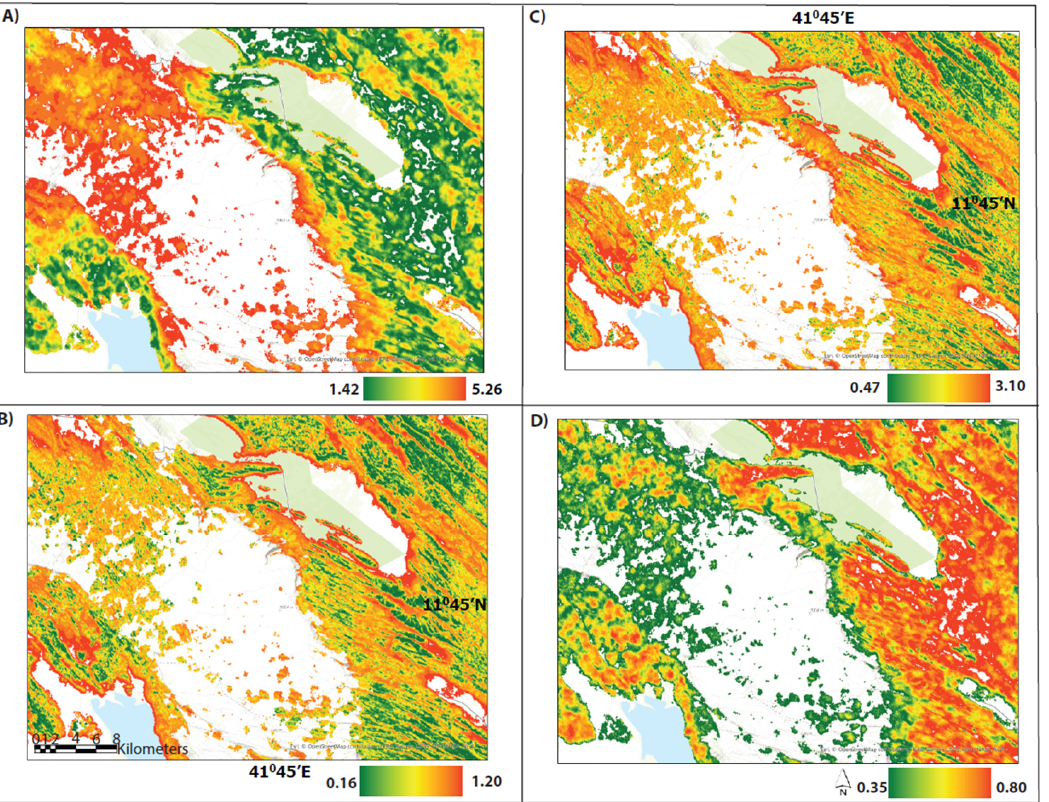
Figure 5. The quality of the InSAR results from descending tract 006 needed to be checked using several indices: ( A ) The Root Mean Square Error (RMSE); ( B ) Height Precision (HP); ( C ) Velocity Precision (VP) and ( D ) multi-temporal interferometric coherence, where the red-colored area is highly coherent. All the quality-control indices have a direct link to the quality of the phase-changes in both the ascending and descending tracts.